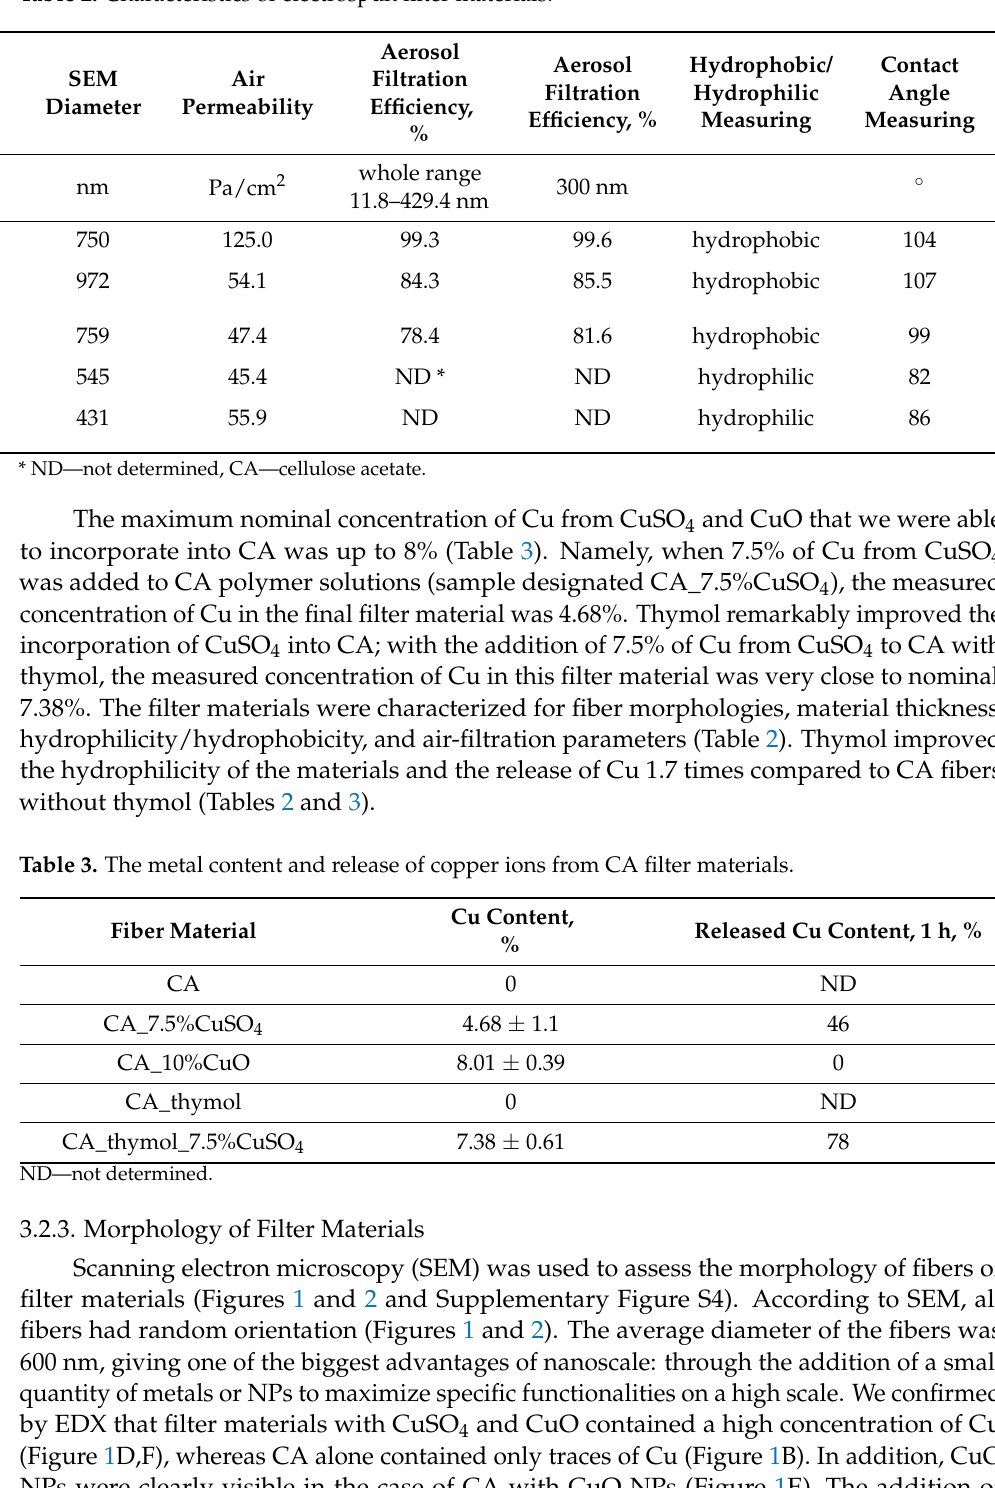
Table 2. Characteristics of electrospun filter materials.